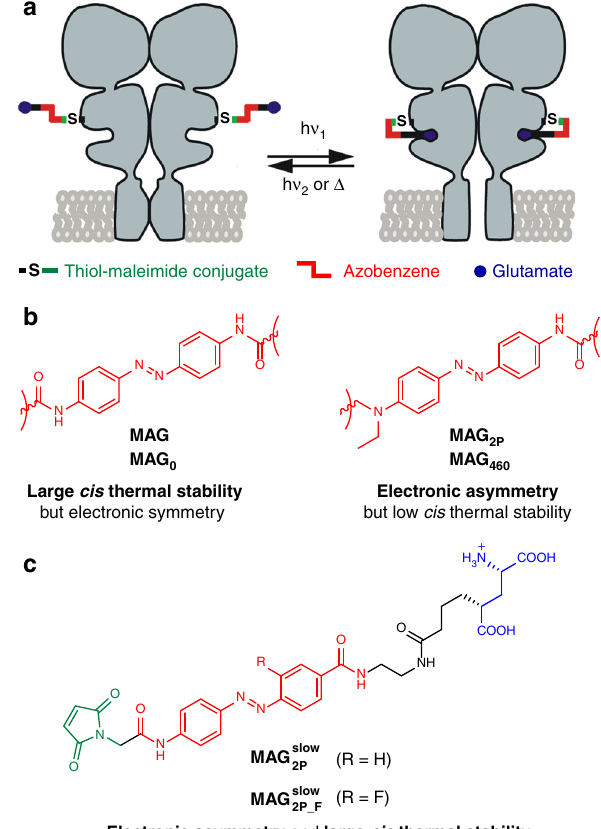
Fig. 1 Strategy toward optimized azobenzene photoswitches for the two- photon (2P) excitation of light-gated glutamate receptors (LiGluR). a Operating mode of MAG-type photoswitchable tethered ligands (PTLs) on LiGluR, which are composed of three covalently tethered units: a glutamate ligand, an azobenzene core, and a maleimide group that binds to a cysteine residue genetically engineered in the receptor. Ultraviolet-visible (one-photon; 1P) or near-infrared (2P) light excitation induces glutamate recognition and channel opening via trans → cis isomerization, which results in ion fl ow across the membrane. This process is reverted by illumination with visible light excitation (1P) or thermal back-isomerization of the cis state of the switch. b Structures of the azobenzene cores of MAG , MAG 0 , MAG 2P , and MAG 460 PTLs proposed for the photoswitching of LiGluR under 1P and 2P excitation conditions. c Structures of PTLs MAG slow MAG slow 2P (cid:1)